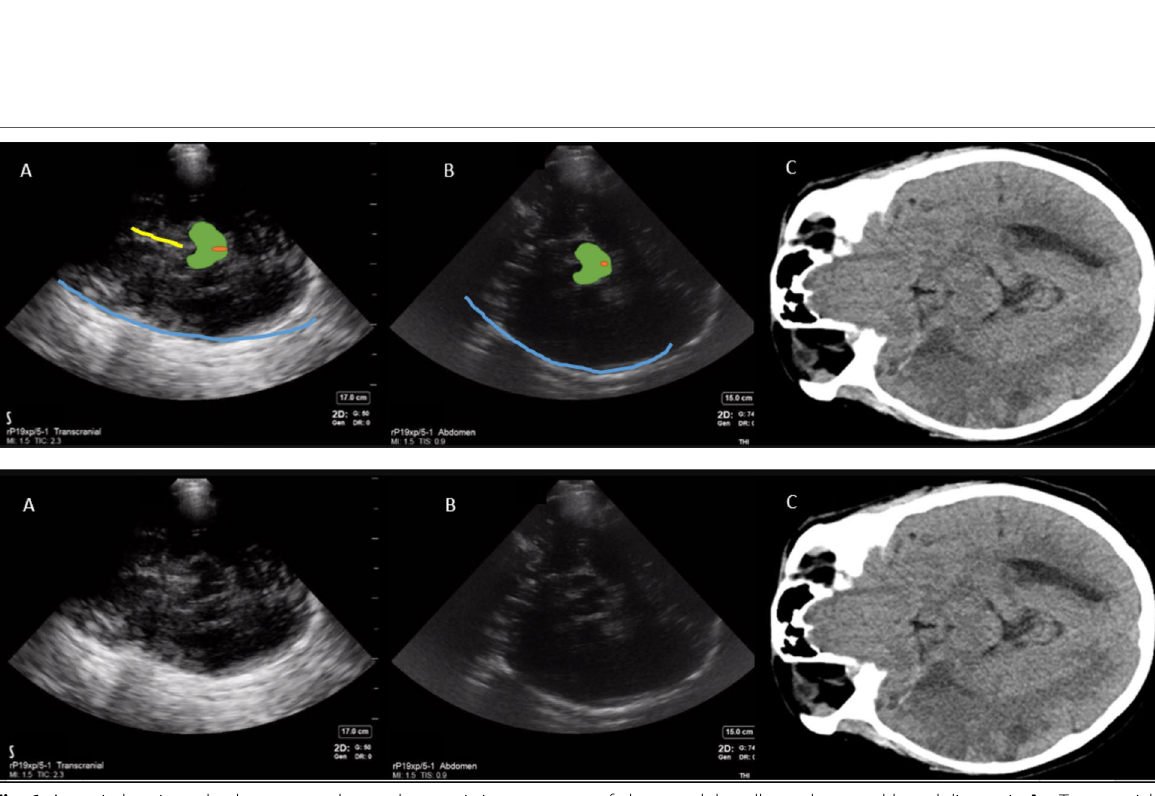
Fig. 6 Acute ischemic stroke does not produce a characteristic appearance of ultrasound that allows ultrasound-based diagnosis. A —Transcranial preset, B —abdominal preset, C —computed tomography brain scan. Blue line—opposite skull, green midbrain, orange dot inside the midbrain— cerebral aqueduct, yellow line—falx